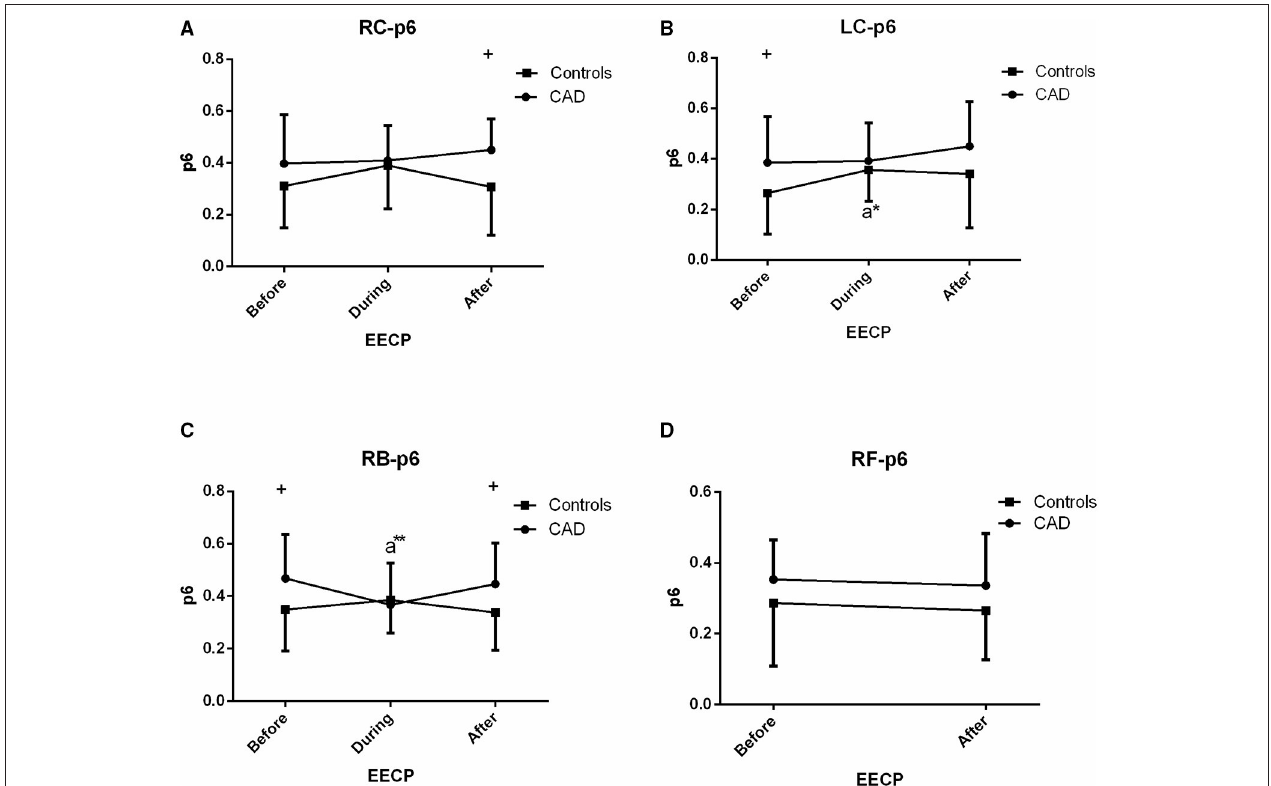
FIGURE 8 | Effect of EECP on the PSER in the 0–0.87Hz (p6) of LC and RC arteries (A,B) , RB artery (C) , and RF artery (D) in patients with CAD and controls before, during and after 45-min EECP. a indicates significant differences in measurements obtained during EECP vs. pre-EECP. “*” and “**” denote values of p < 0.5 and < 0.01,